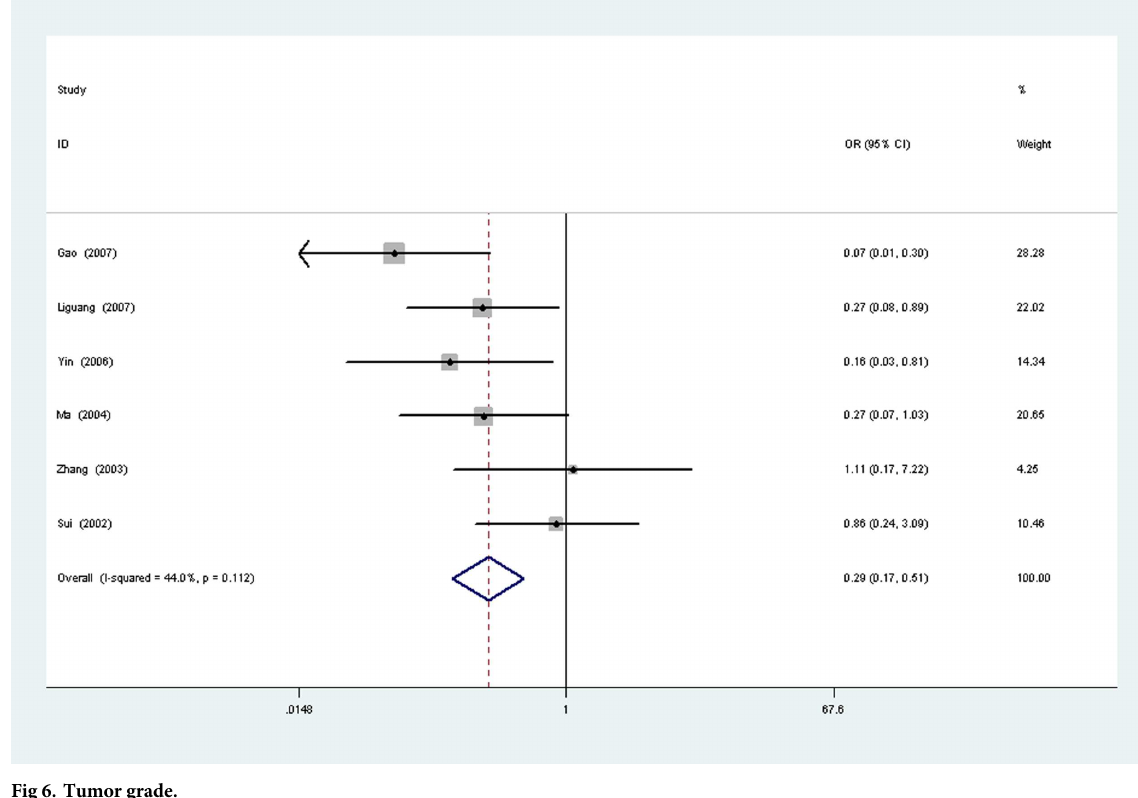
grade. The differences of I—II compared with III—IV, G1-G2 compared with G3 were statisti-